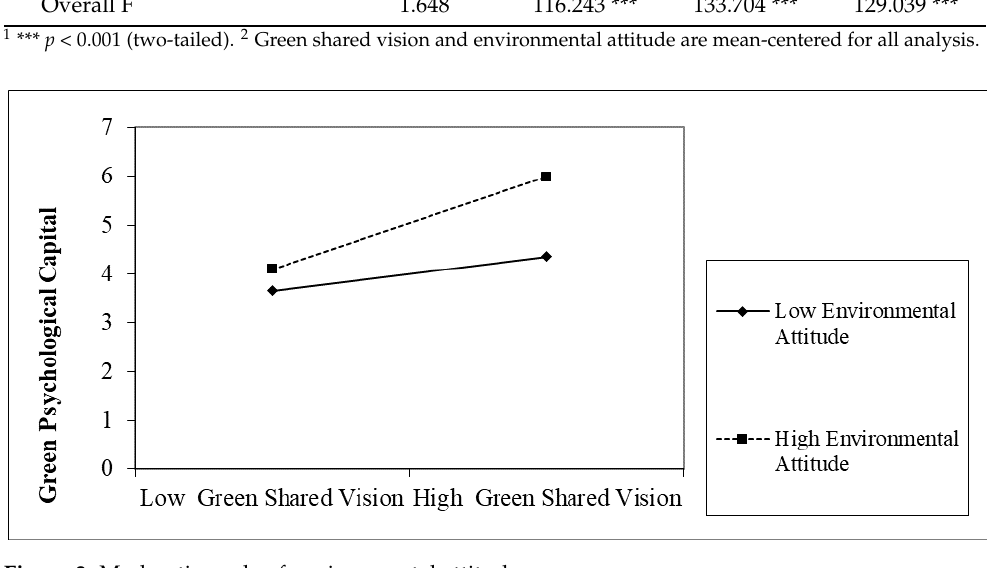
Figure 3. Moderating role of environmental attitude. Table 7. Indices of moderated